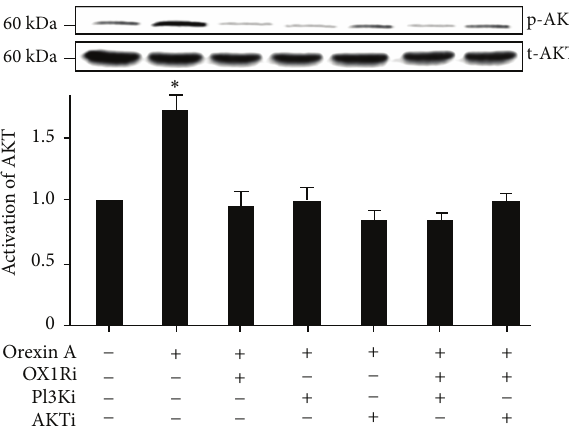
Figure 6: Effects of OXA on caspase-3 activity in INS-1 cells. Cells were treated with or without OXA (10 −6 M) for 24h in the presence or absence of PF-04691502 (AKTi) (10 −6 M), wortmannin (PI3Ki) (10 −8 M), SB334867 (OX1Ri) (10 −6 M), or a combination of these antagonists. Caspase-3 activity was assessed using a caspase- 3 colorimetric assay kit. Data are presented as mean ± SEM based on triplicate determinations from a representative experiment. Asterisks indicate significant differences as compared to control ( ∗∗ 𝑃 < 0.01) .